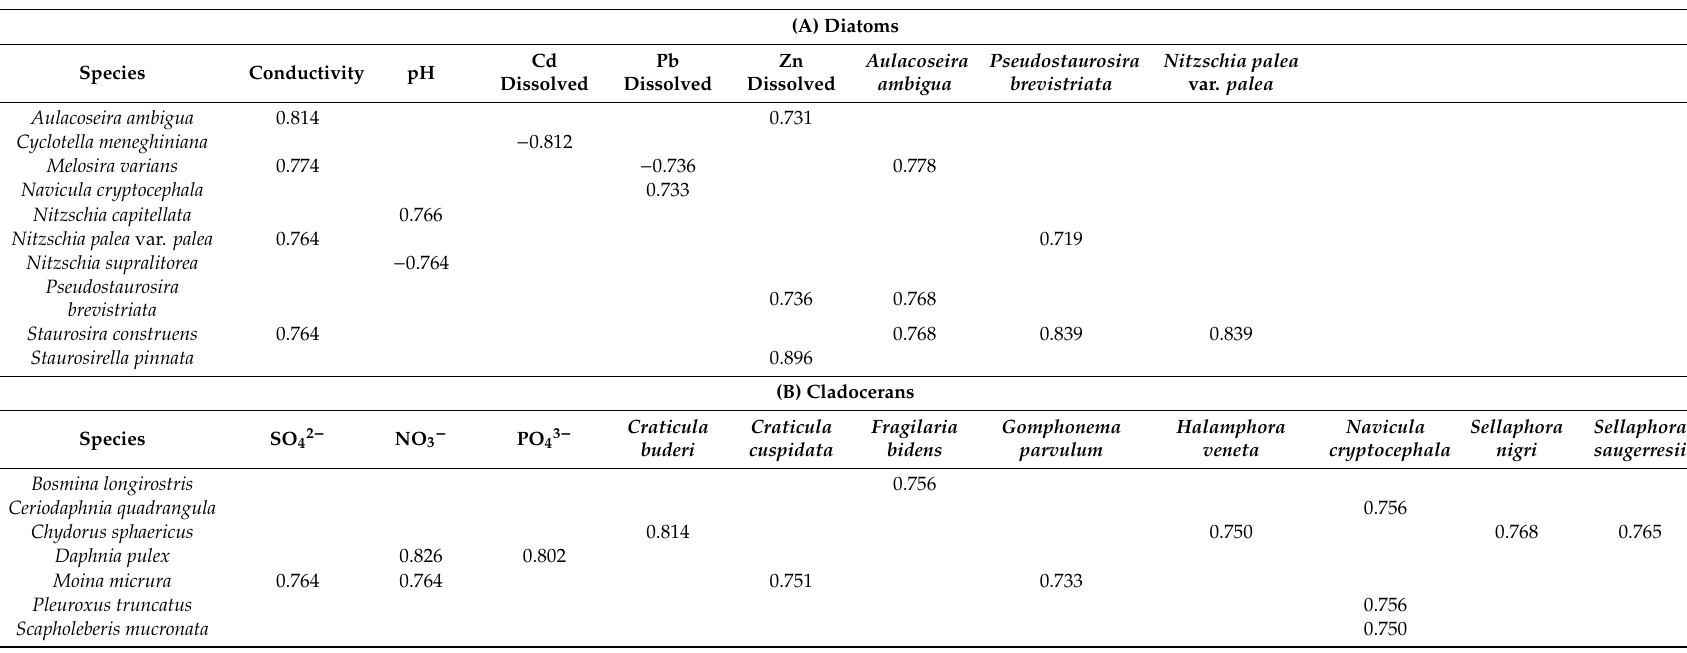
Table 5. Spearman’s rank order correlation for planktonic diatoms (A) and cladocerans (B) from pond created after mine was closed (UP). (A)